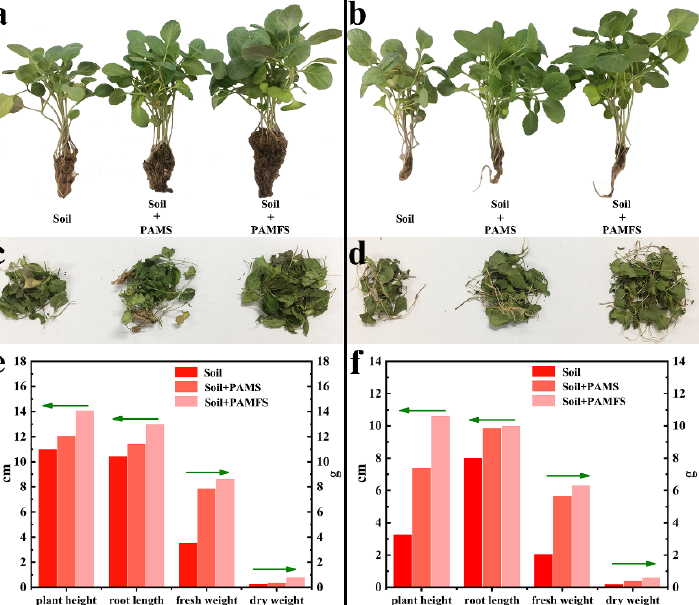
Figure 8. D igital photos of seedlings ( a ), dried seedlings ( c ) and early-stage seedling growth parameters ( e ) under the condition of abundant water and being irrigated the same amount of water every 4 days. Dgital photos of seedlings ( b ), dried seedlings ( d ) and early-stage seedling growth parameters ( f ) under limited water conditions and being irrigated the same amount of water every 8 days.